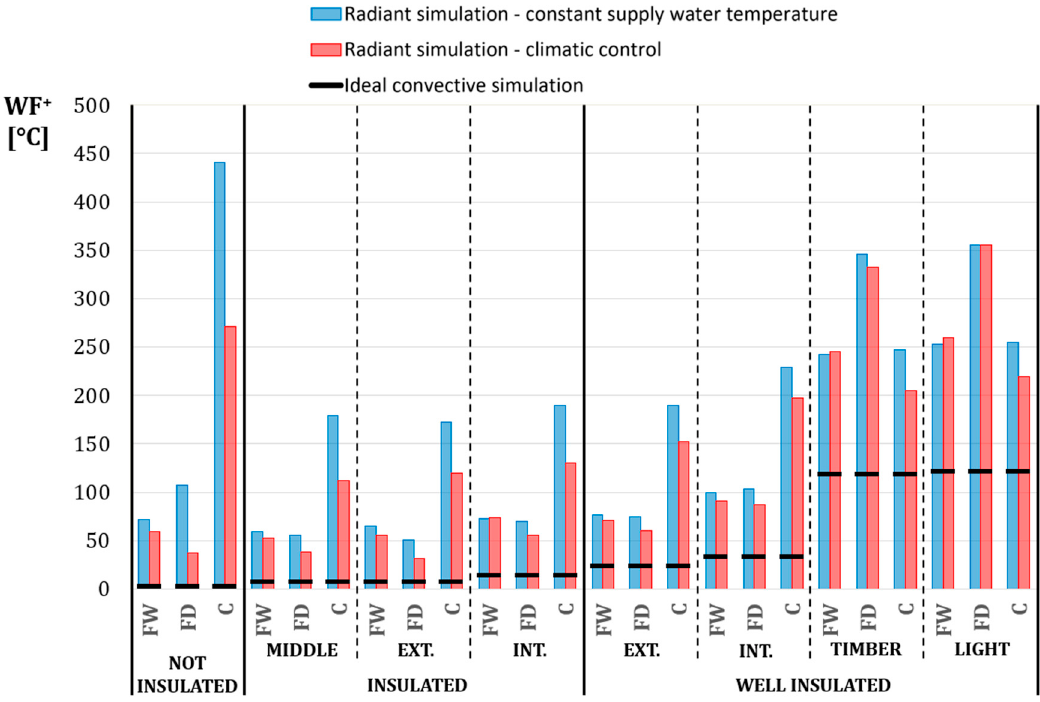
Figure 11. Weighed time in the radiant cases and in the equivalent ideal convective ones.